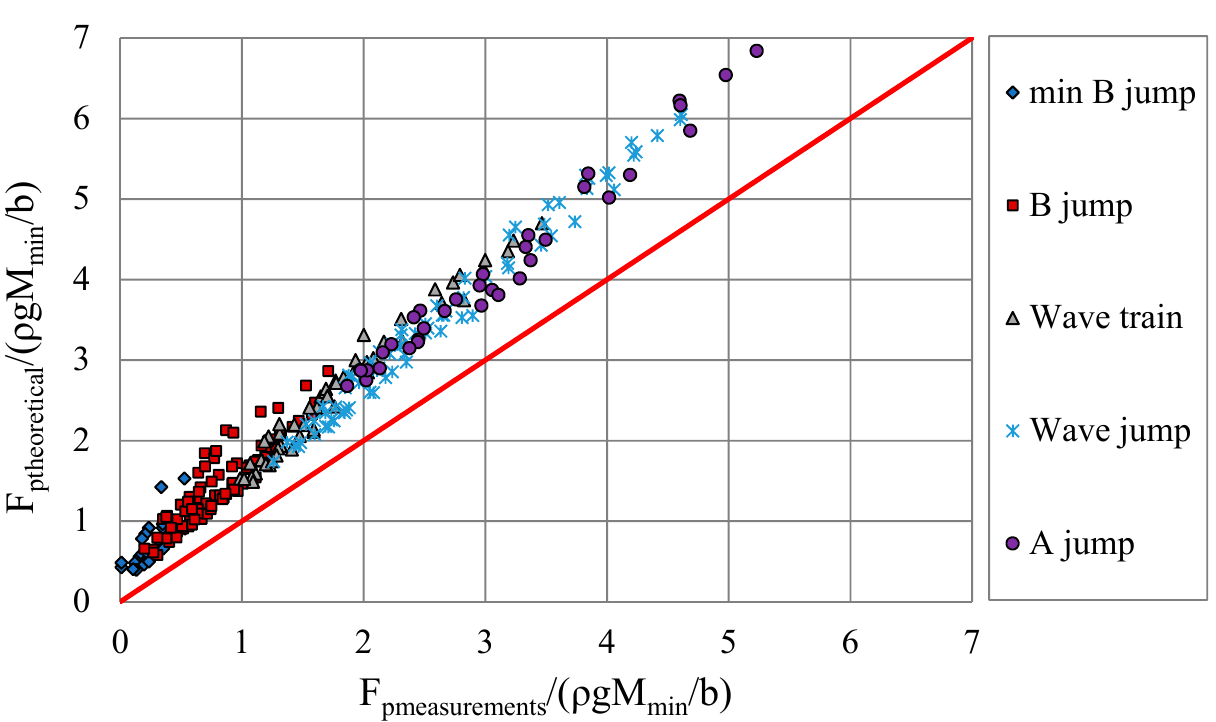
Figure 11. Dimensionless maximum pressure head at the bottom of the channel downstream of the step, versus y 2 /(y c + d) for all types of jumps.